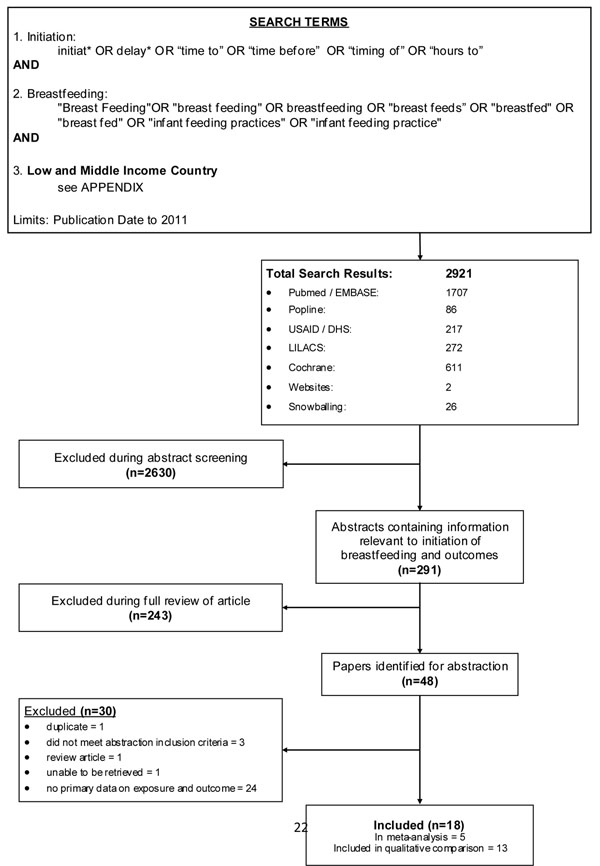
Flow diagram of systematic review